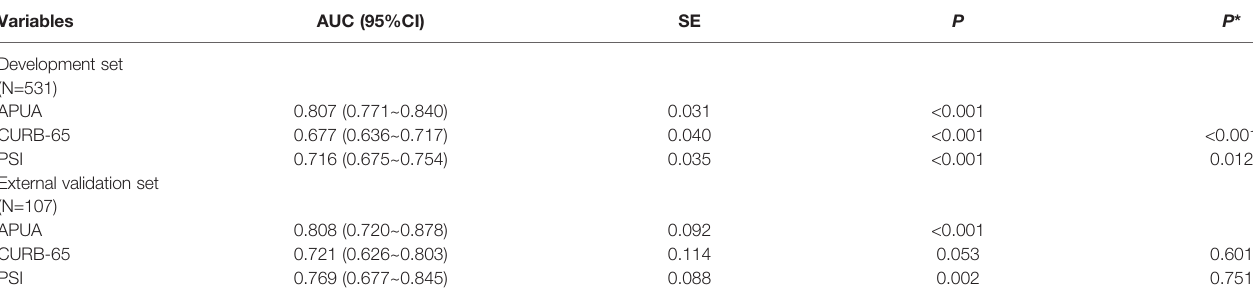
TABLE 3 | The accuracy of APUA, CURB-65, and PSI score for evaluating the risk of short-term outcome in community acquired pneumonia patients with diabetes.